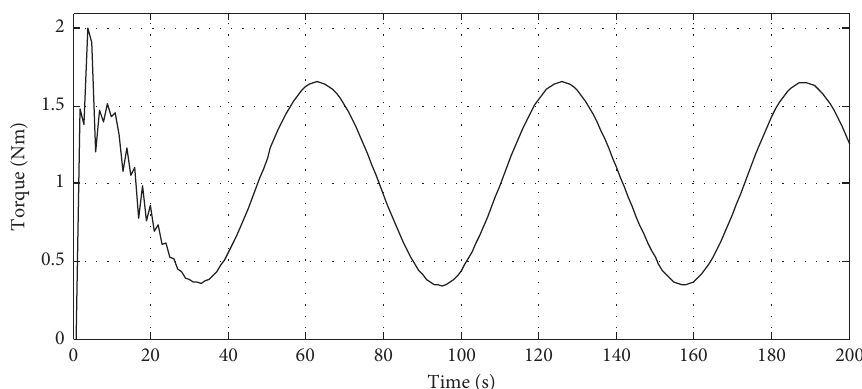
Figure 11: Normal PMSM torque (parameters constant).